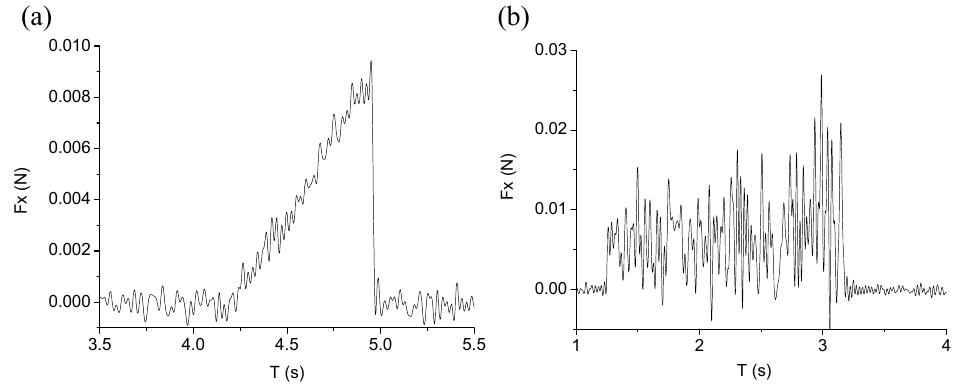
Figure 11. Variation of feed cutting force with cutting speed of 300 mm/min: ( a ) BK7; ( b ) Fused